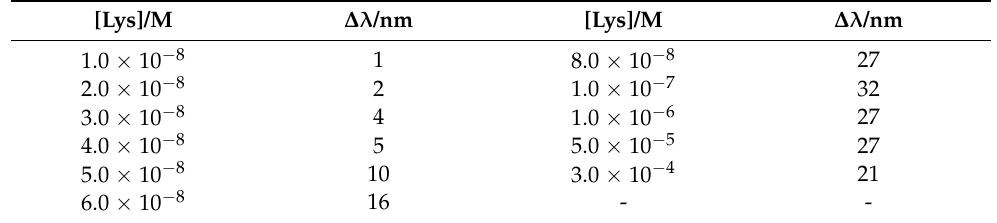
Figure 10. Experimental spectra of 10 nm AuNPs solutions on the visible region showing the red and blue shift in function of the Lys concentration. [AuNPs] = 3.28 × 10 − 9 M. The blue arrow points the shift of the SPB according the Lys concentration increases; the red dashed arrow highlights the reversal of the band at highest concentrations. Table 3. Values of Δ λ /nm at different protein concentrations. [AuNPs (10 nm)] = 3.28 × 10 − 9 M.